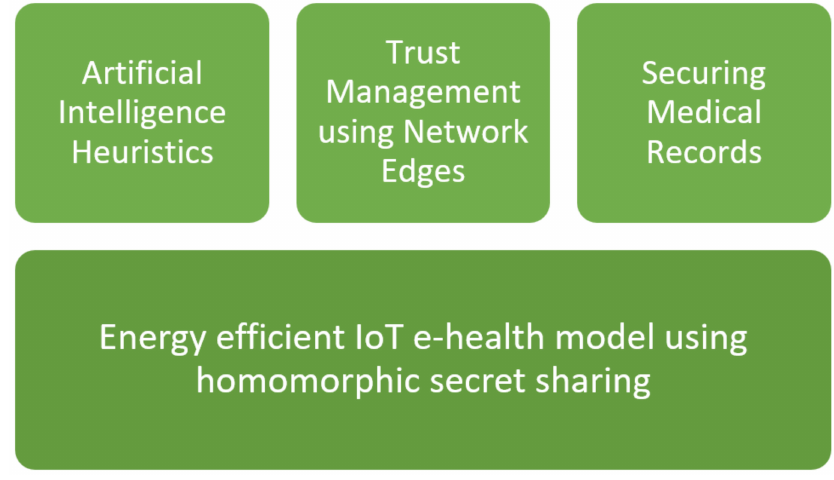
Figure 1. Block diagram of the proposed